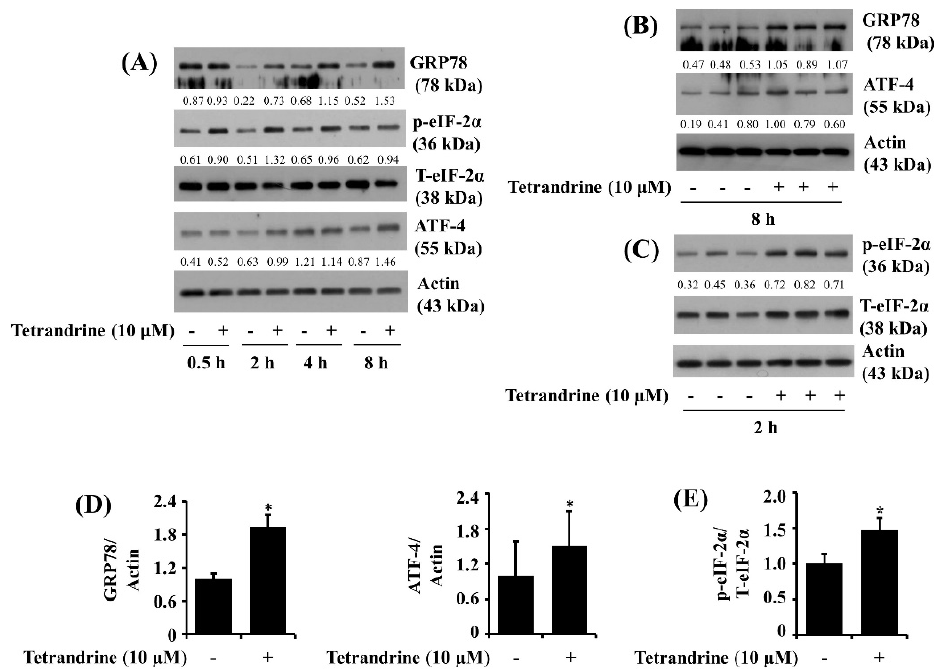
Figure 6. Effects of tetrandrine on the expression and phosphorylation of GRP78, eIF-2 α , and ATF-4 in SW872 cells. ( A ) SW872 cells were treated with vehicle control (0.1% DMSO) or tetrandrine at 10 µ M for the indicated time point. Whole-cell lysates from the conditioned cells were extracted and analyzed to measure the expression of GRP78, p-eIF-2 α , eIF-2 α , ATF-4, or β -actin by Western blotting. ( B , C ) SW872 cells were treated with vehicle control (0.1% DMSO) or tetrandrine at 10 µ M tetrandrine in triplicate for 8 h ( B ) or 2 h ( C ). Whole cell lysates from the conditioned cells were extracted and analyzed to measure the expression of GRP78, ATF-4, p-eIF-2 α , eIF-2 α , or β -actin by Western blotting. ( D , E ) are densitometry data of ( B , C ), respectively. * p < 0.05 was compared to the value of tetrandrine-free control at the indicated concentrations.